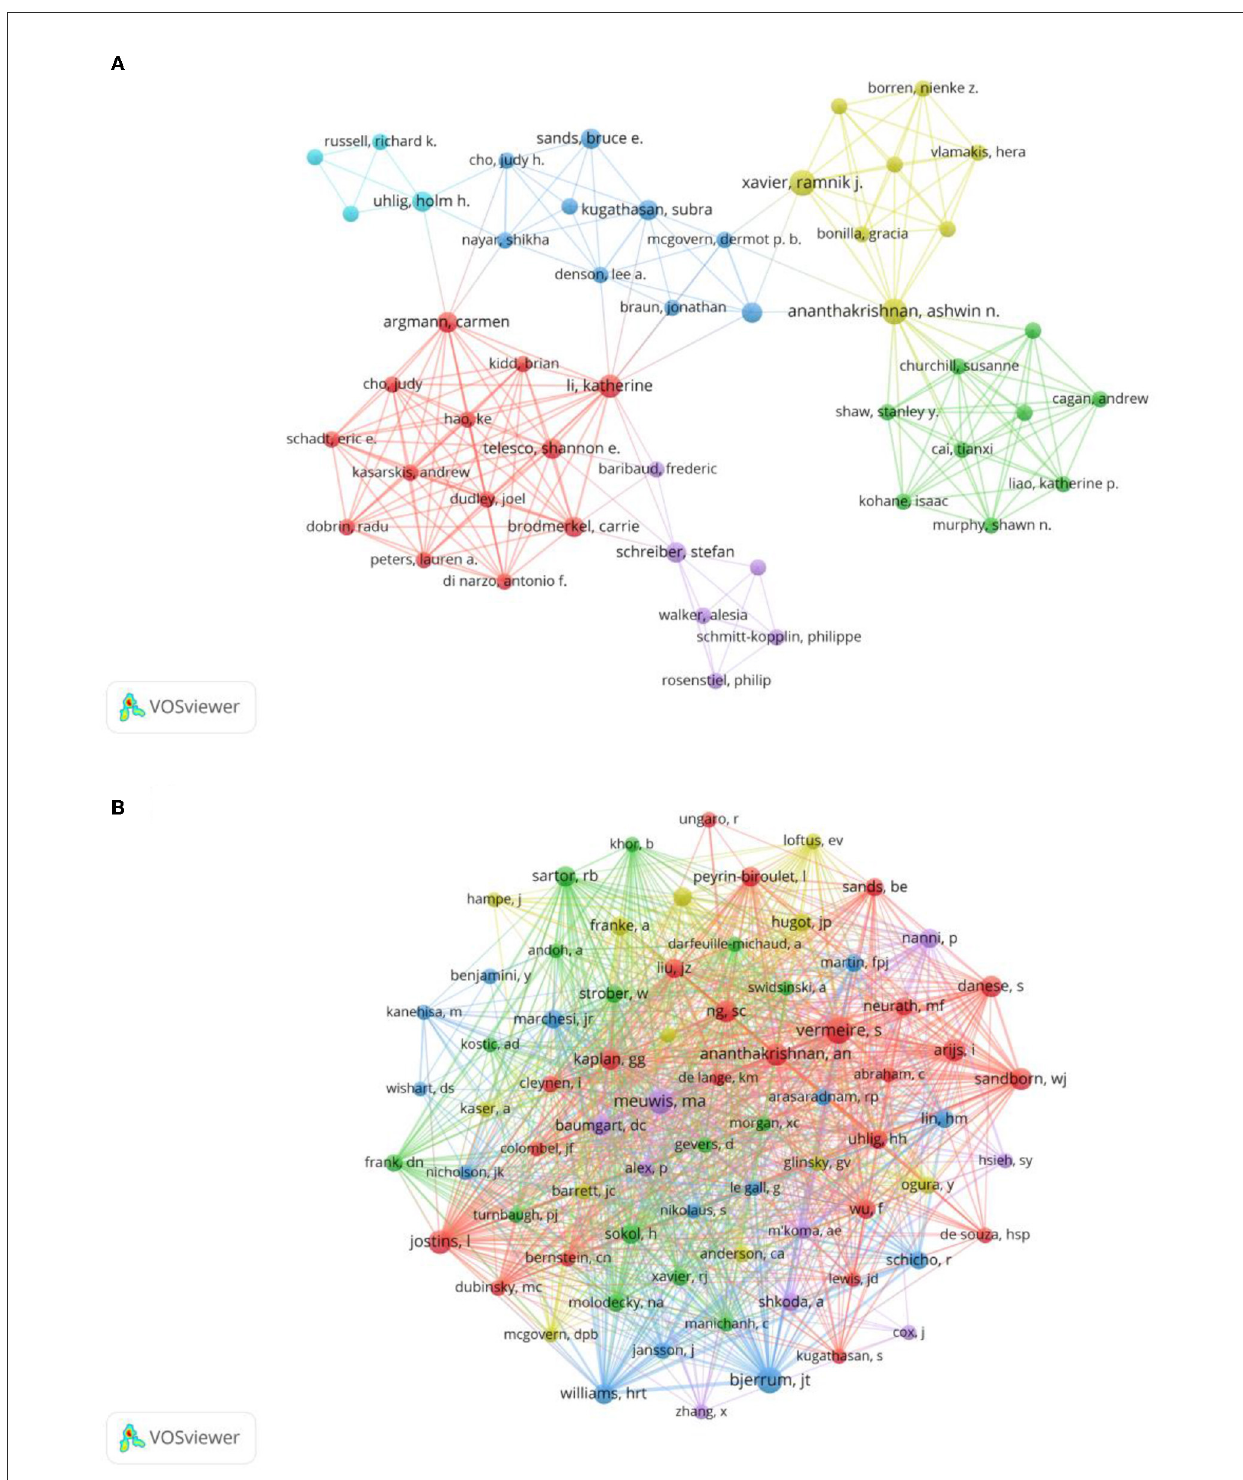
FIGURE4 (A) Network of authors on research of omics in UC. (B) Network of co-cited authors on research of omics in UC.